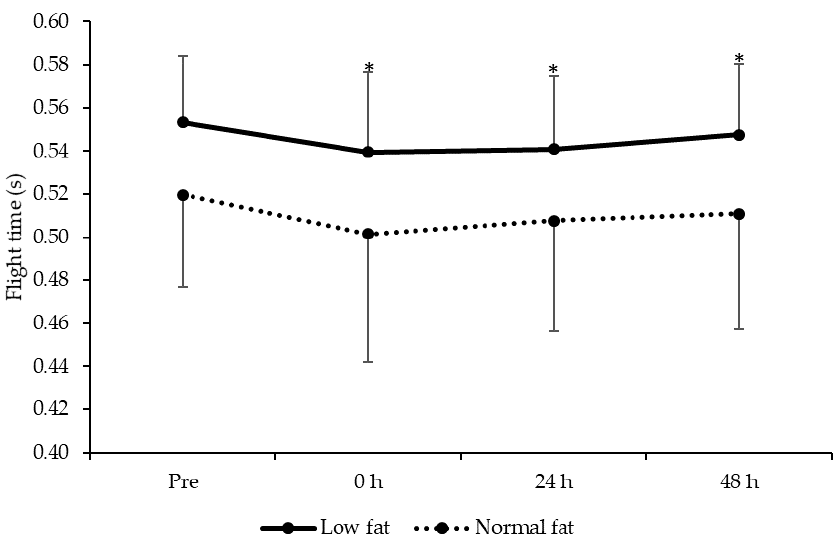
Figure 6. Changes in flight time (mean ± standard deviation) between low- and normal-fat groups at pre, 0, 24 and 48 h after resistance exercise. * denotes significantly different from pre for the whole sample ( P < 0.05).